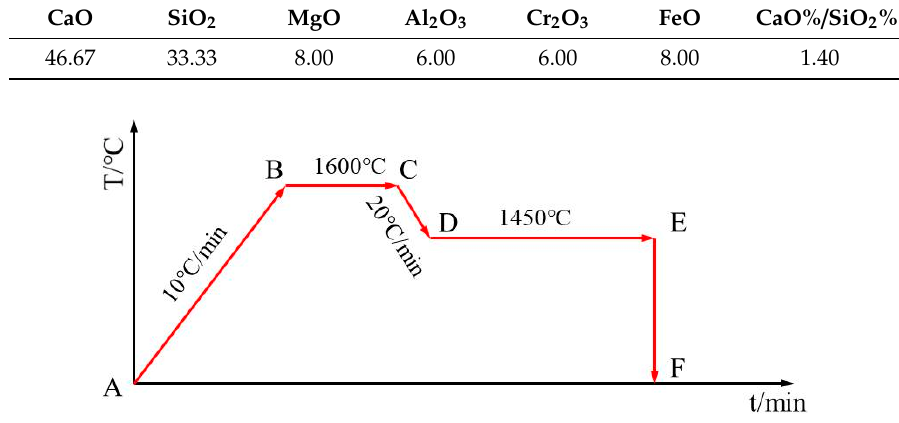
Figure 1. The heating procedure adopted in the experiments.